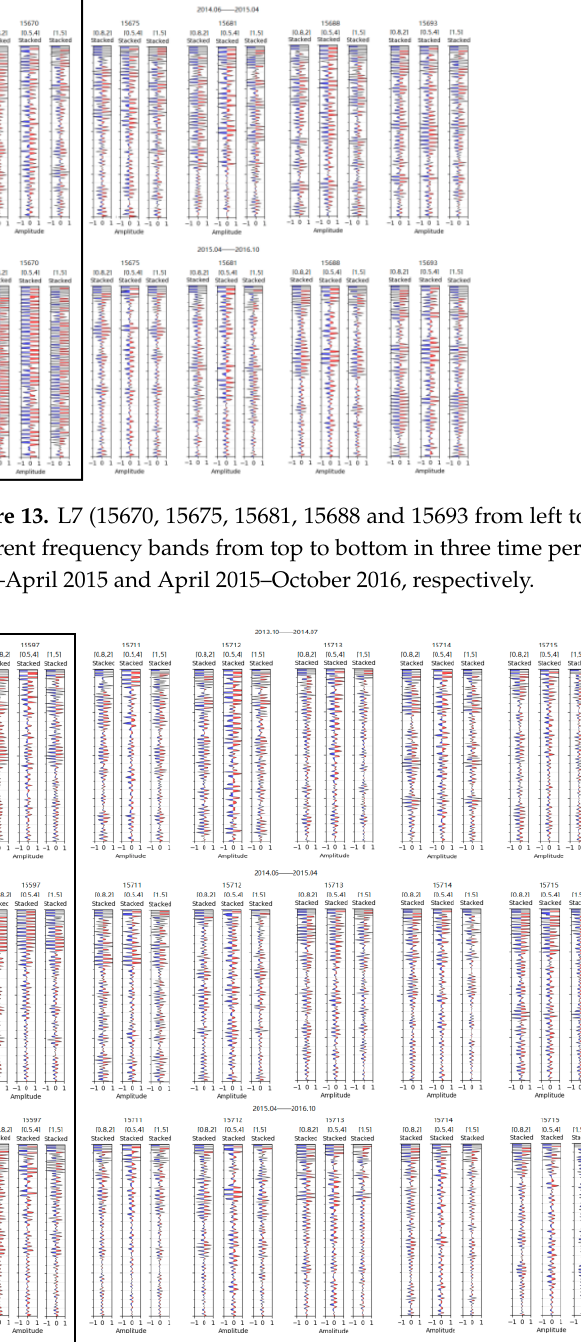
Figure 14. L9 (from left to right: 15597, 15711, 15712, 15713, 15714 and 15715) from top to bottom are